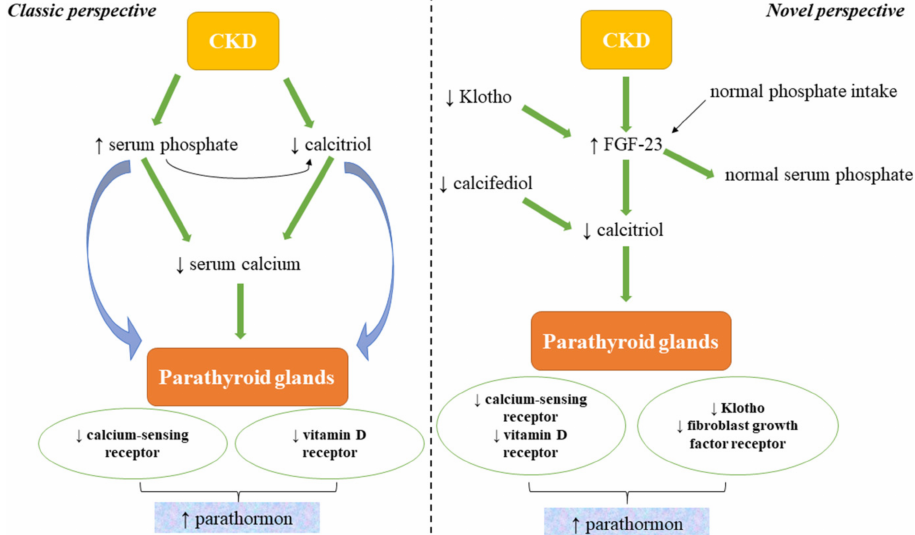
Figure 1. The classic and novel perspectives of CKD–MBD pathophysiology (modified after [8]). CKD: chronic kidney disease; FGF-23: fibroblast growth factor 23; calcifediol: 25-hydroxyvitamin D; calcitriol: 1,25-dihydroxyvitamin